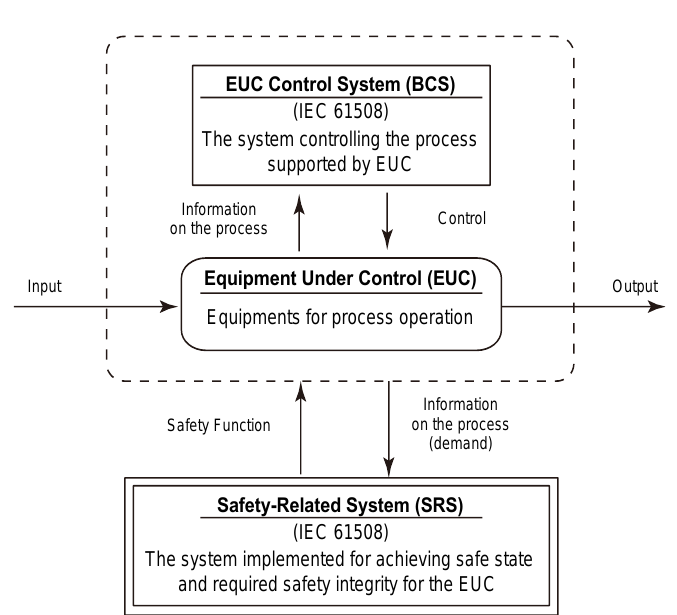
Figure 1. Basic configuration of the whole system including E/E/PE